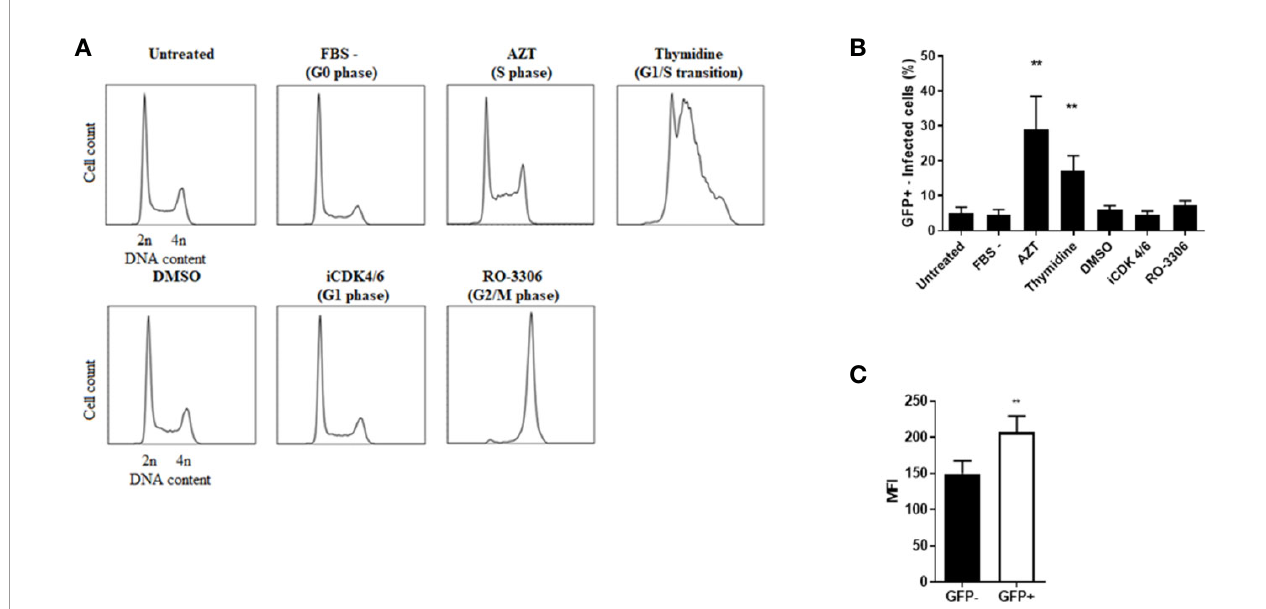
FIGURE 8 | Rck-mediated internalization is facilitated in S-phase cells. HCT116 cells were synchronized at different phases of the cell cycle as indicated. (A) Cell cycle was analyzed on synchronized cells using fl ow cytometry after DNA labelling with propidium iodide. Representative histograms of DNA content for 30,000 events acquired are shown, representative of three independent experiments. (B) The synchronized cells were then infected with MC-RckGFP strain for 30 min at a MOI of 10 and the percentage of infected cells was determined according to GFP fl uorescence. (C) HCT116 cells were infected with MC-RckGFP strain for 1 h at a MOI of 100. At 6 h p.i., the distribution of EGFR was quanti fi ed on the cell surface of sorted GFP − and GFP+ infected cells by fl ow cytometry using a speci fi c anti- EGFR antibody. The MFI was estimated as described in Materials and Methods . Results are mean ± SD of results obtained in triplicate from two independent experiments with 30,000 events acquired per experiment. Data were compared using a Mann-Whitney test (**p <